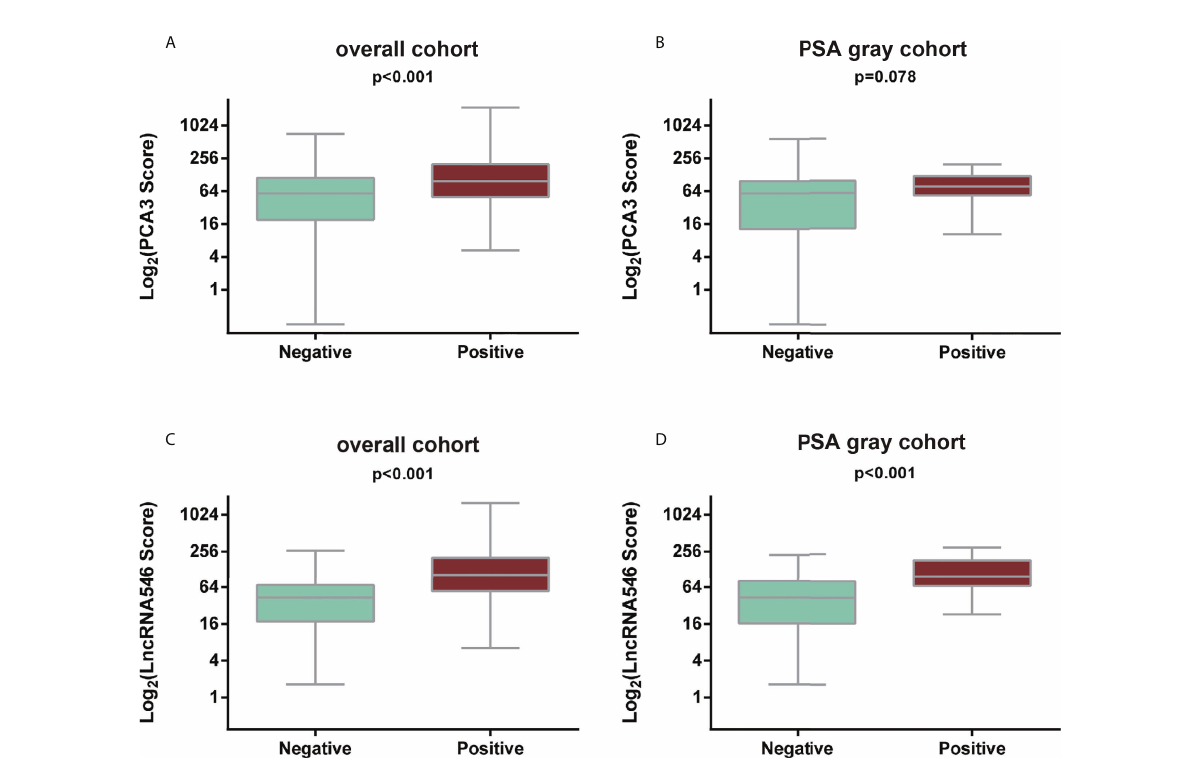
FIGURE 2 Comparison of PCA3 and LncRNA546 scores between positive and negative biopsies in two cohorts. (A) PCA3 score in the overall cohort. (B) PCA3 score in the PSA gray area cohort. (C) LncRNA546 score in the overall cohort. (D) LncRNA546 score in the PSA gray area